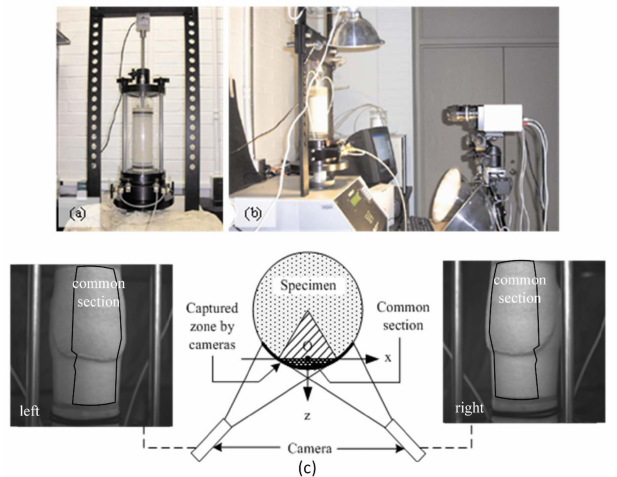
Figure 2. The experimental setup: ( a ) triaxial compression system; ( b ) the 3D-DIC system; ( c ) a schematic illustration of a common section captured by two camera